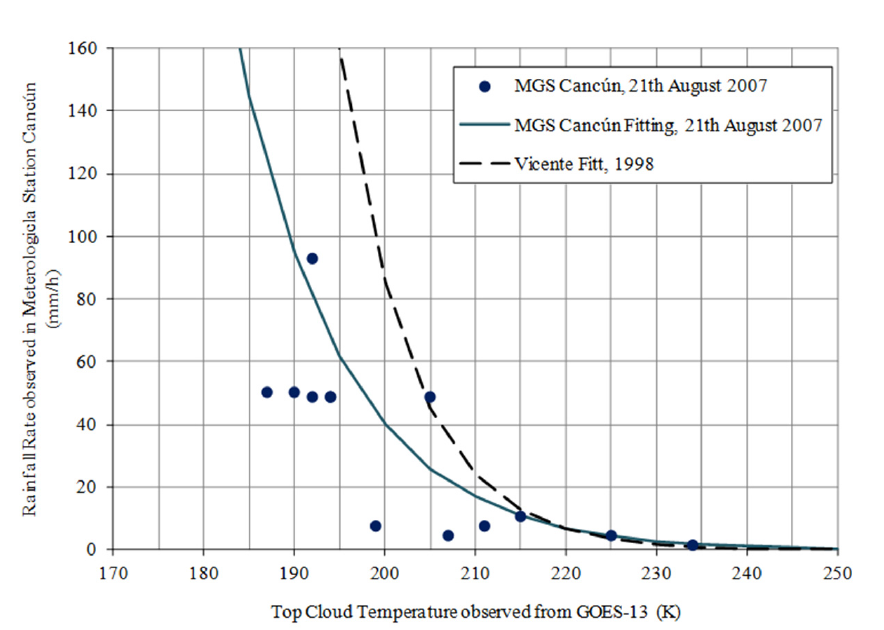
Figure 2. The relationship (R 2 = 0.55) between rainfall, the intensity from MGS Cancun 21 August 2007, and temperature of cloud top from the satellite image on the same date of Hurricane Dean.